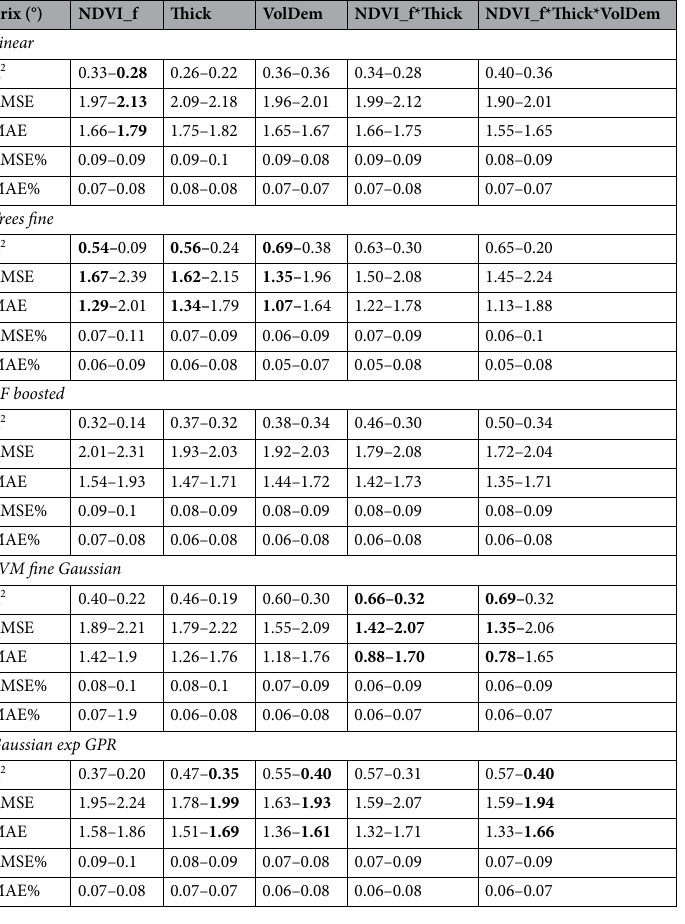
Table 6. Regression model’s performance (R 2 , RMSE, MAE, RMSE%, MAE%) obtained from the complete dataset (2017–2018–2019) between total soluble solids and NDVI filtered (NDVI_f), canopy thickness (Thick), canopy volume (VolDem), NDVI filtered and canopy thickness (NDVI_f Thick), NDVI filtered, canopy thickness and canopy volume (NDVI_f Thick VolDem). Each cell presents 2 values, the first calculated without cross validation, and the second using fivefold cross validation. The best resulting models are bold typed.